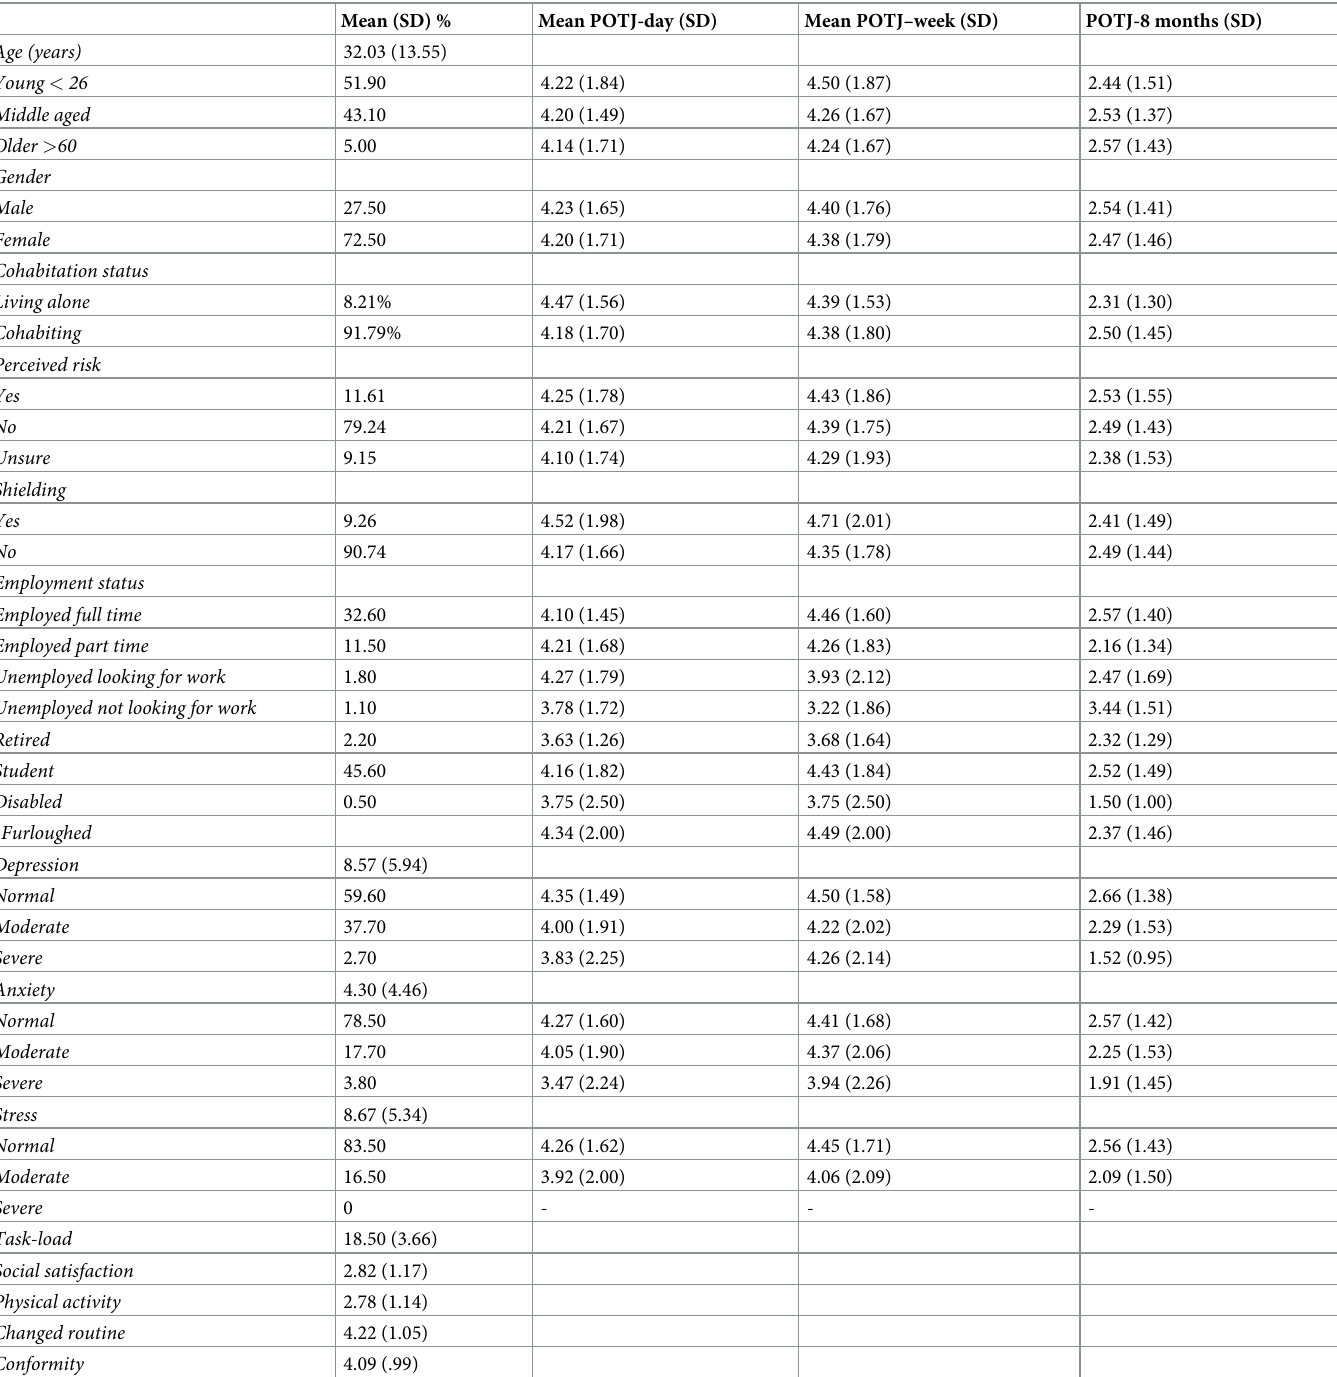
Table 1. Descriptive statistics of the proportion of participants in different demographic groups and the mean POTJ for each